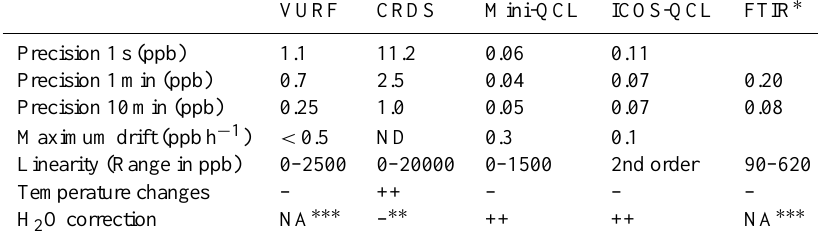
Table 1. Performance summary of the tested CO analysers.